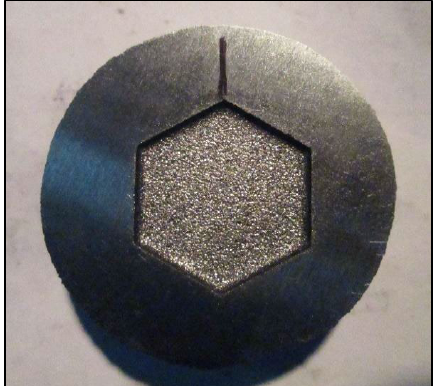
Figure 3. Machined workpiece.